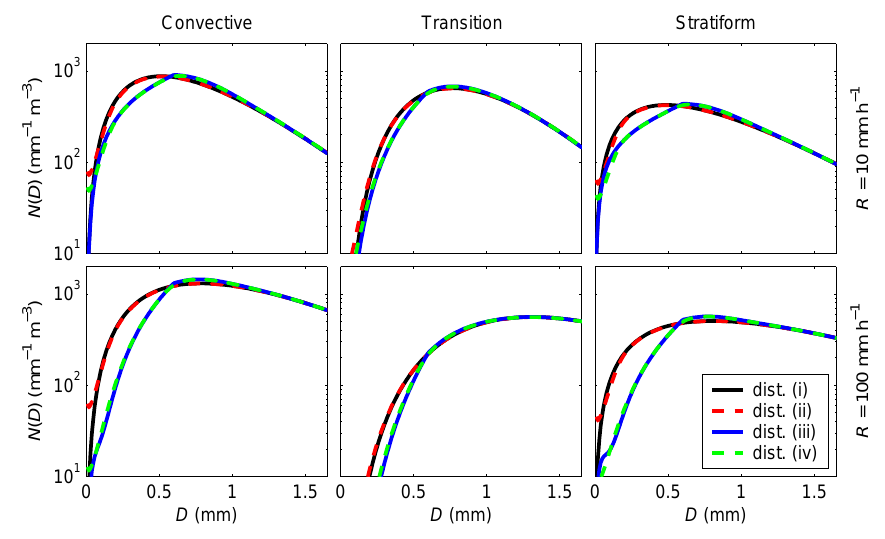
Fig. 4. Comparisons of DSDs derived using simulated measurements from a JWD, using underlying gamma DSDs for the three different types of rainfall. Results are shown for the four velocity ratio distributions listed in Table 1. Analyses are shown for R = 10mmh − 1 (top panels) and R = 100mmh − 1 (bottom